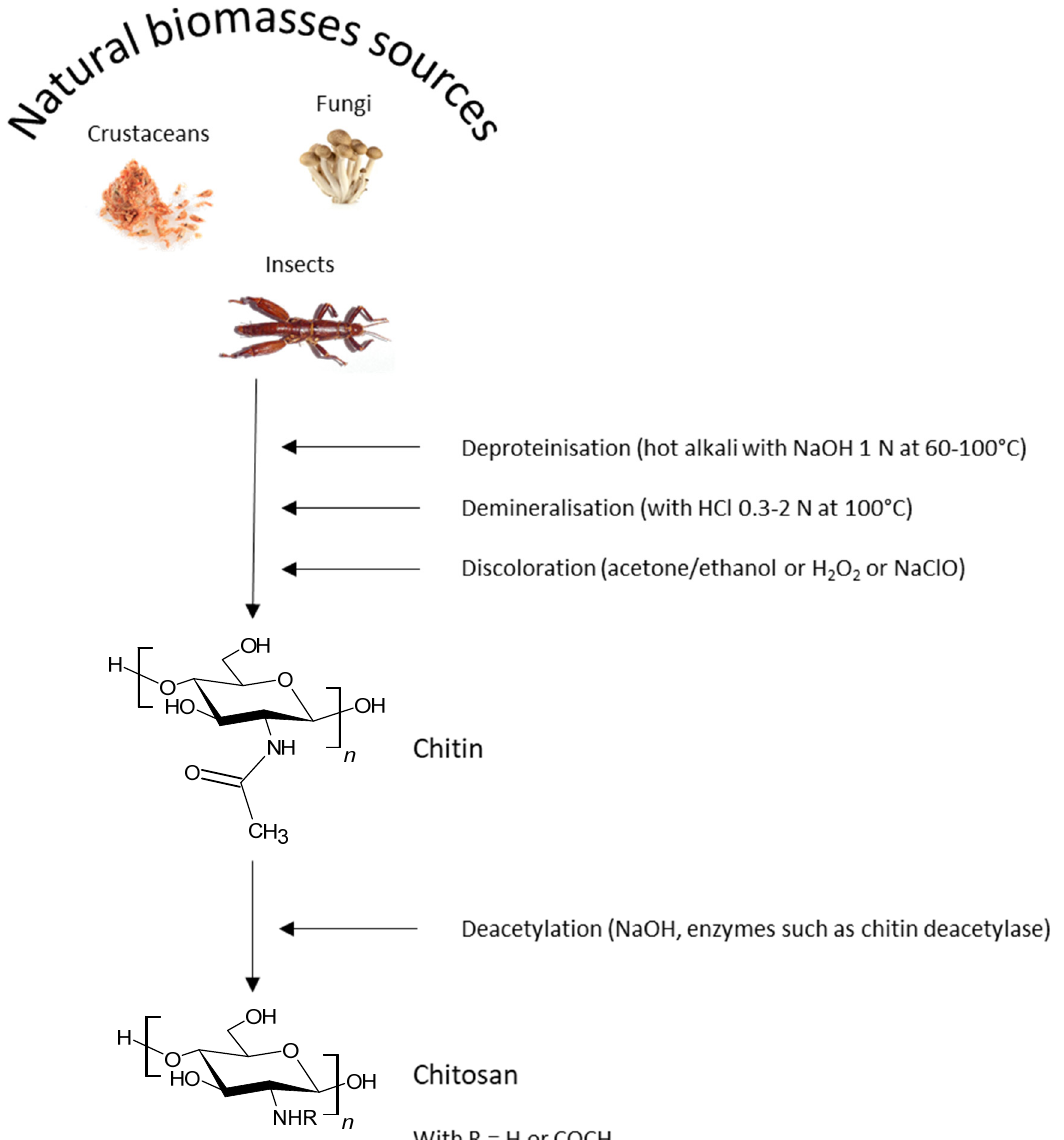
Figure 1. General processes for chitosan production